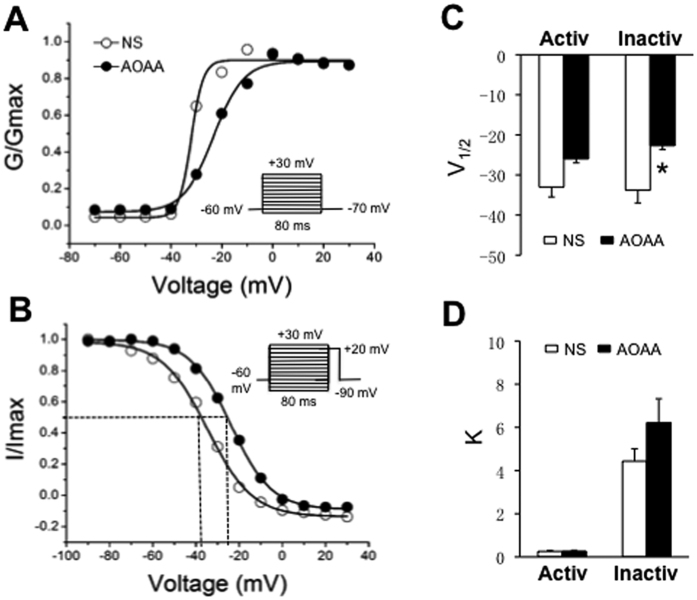
Effect of CBS inhibitor on activation and steady-state inactivation curves of sodium currents.(A) For activation curves, the sodium currents were generated by 2 voltage pulses in 10 mV increment steps from −70 to +30 mV in a DiI-labeled DRG neuron from a rat treated with NS and a rat treated with AOAA. The reversal membrane potential (Vrev) in this recording condition was +78 mV. At different test potentials, membrane conductance (G) was measured by dividing the peak sodium current by the current driving force (Vm-Vrev) and was normalized to that recorded at +30 mV (Gmax). Data were fitted with the modified Boltzmann equation: G/Gmax = 1/{1-exp[(V-V1/2)/k]}, where V is membrane potential, V1/2 (V half) is the membrane voltage at which the current was half-maximally activated, and k is the slope factor. AOAA treatment did not alter the activation curve compared with NS group. There were no significant differences of V1/2 (C) and k (D) between NS and AOAA group. (B) For steady-state inactivation curves, a conditional step of various voltages from −90 to +30 mV with 10 mV increment. These inactivation curves are representative curves of one neuron from a rat treated with NS and one neuron from a rat treated with AOAA, respectively. The peak current amplitude was normalized to that recorded at a −90 mV conditioning step (Imax). Data were plotted as a function of conditional step potentials and fitted with the negative Boltzmann equation: I/Imax = 1/{1-exp[(V1/2-V)/k]}. AOAA treatment induced the inactivation curve rightward shift compared with the control (NS). (C) Bar graphs showed that there was no difference of V1/2 of activation curve between NS and AOAA-treated rats. The V1/2 of activation curve was −26.0 ± 2.9 mV (n = 10) for neurons from AOAA rats and −33.0 ± 2.5 mV (n = 8) for neurons from NS rats (p > 0.05, two sample t-test); However, AOAA treatment significantly reduced the V1/2 of inactivation curves. The V1/2 of inactivation curve was −33.8 ± 3.2 mV (n = 9) for neurons from NS rats and −22.7 ± 3.9 mV (n = 7) for neurons from AOAA-treated rats (*p < 0.05, two sample t-test). (D) AOAA treatment did not significantly alter the k values of activation curves and inactivation curves.